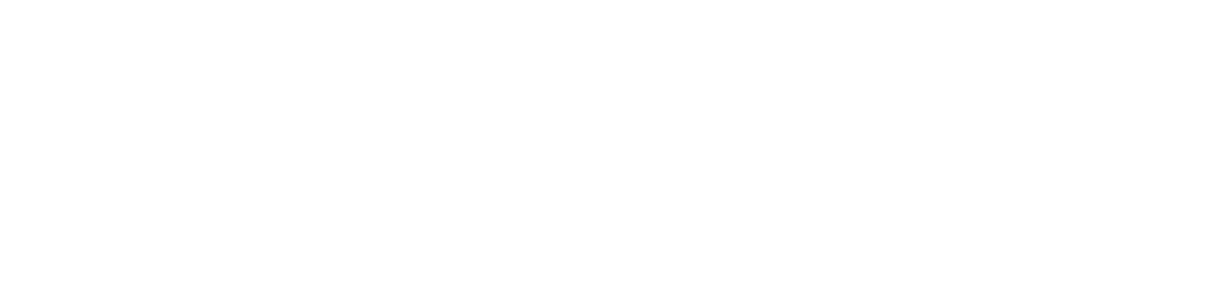
Frontiers in Microbiology | www.frontiersin.org